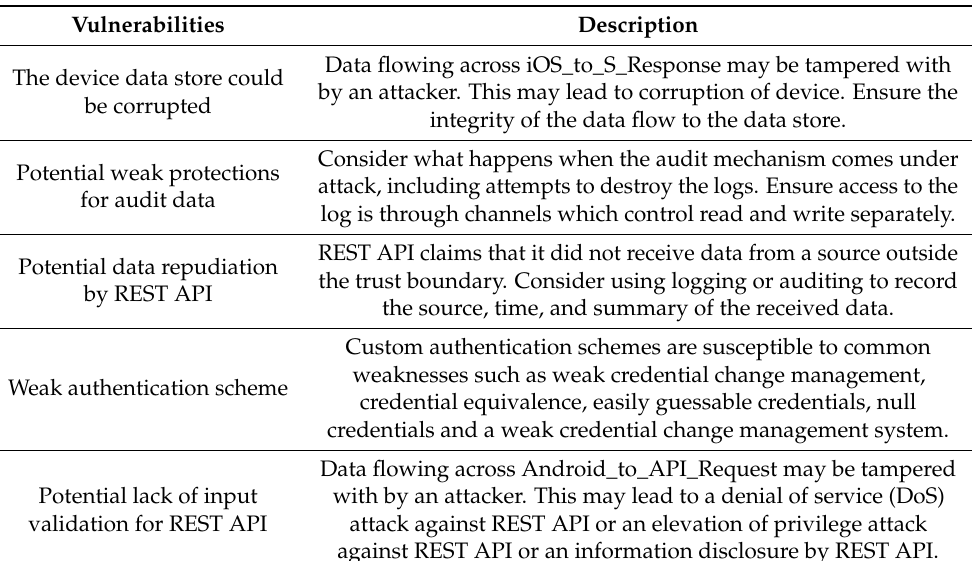
Table 2. Sample vulnerabilities identified using Microsoft TMT tool.